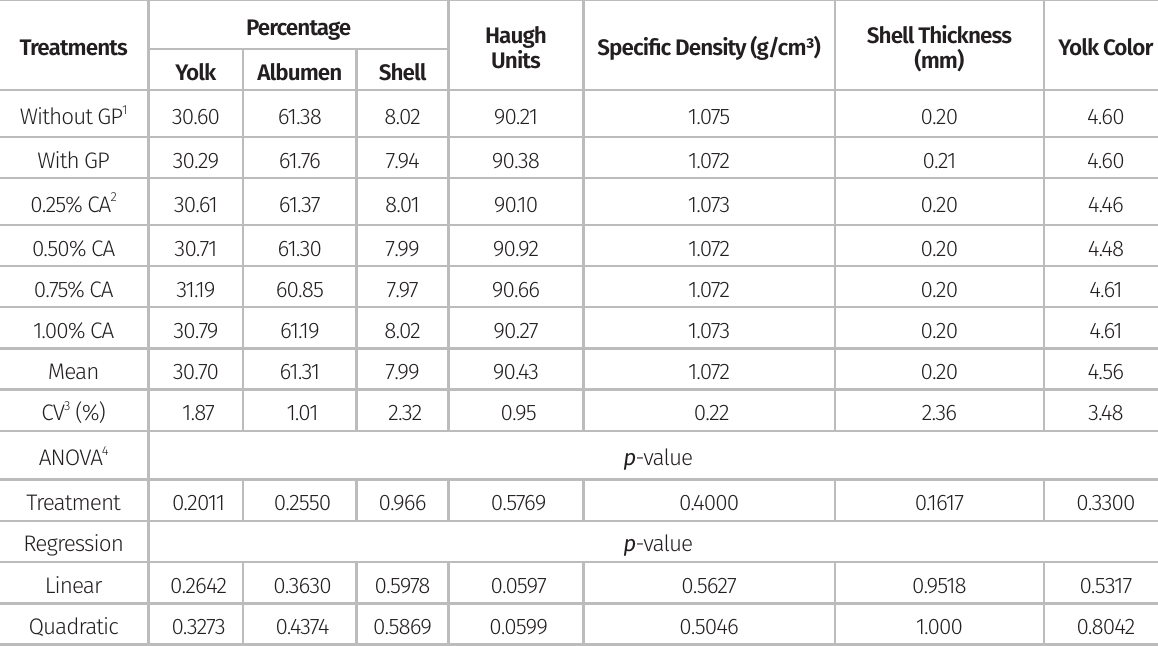
Table III. Components and quality of Japanese quail eggs fed diets with calcium anacardate at various concentrations.